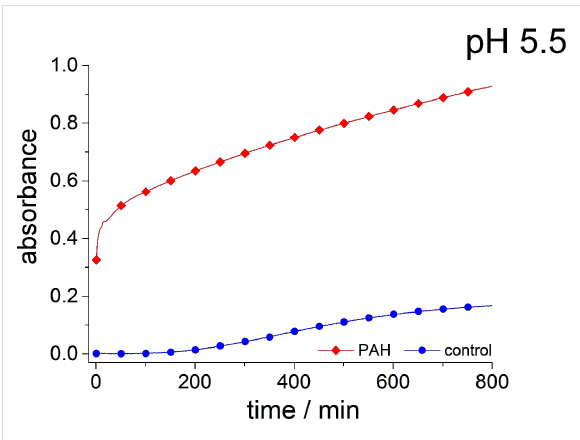
Figure 4: Absorbance of a 90 mM sodium metasilicate solution with 31.25 µM PAH and 180 mM hydrogen phosphate (red rhombuses) and of a sodium metasilicate solution 90 mM containing 180 mM hydrogen phosphate (control, blue circles) measured as a function of time up to 800 min.